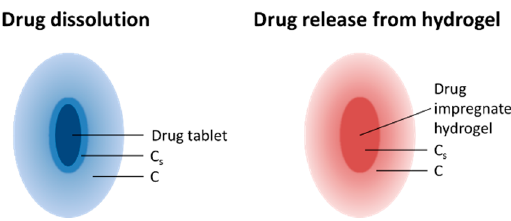
Figure 8. Schematic illustrating the differences in the terms C s and C between the drug dissolution and drug release from a hydrogel used in the First Order Kinetic model.